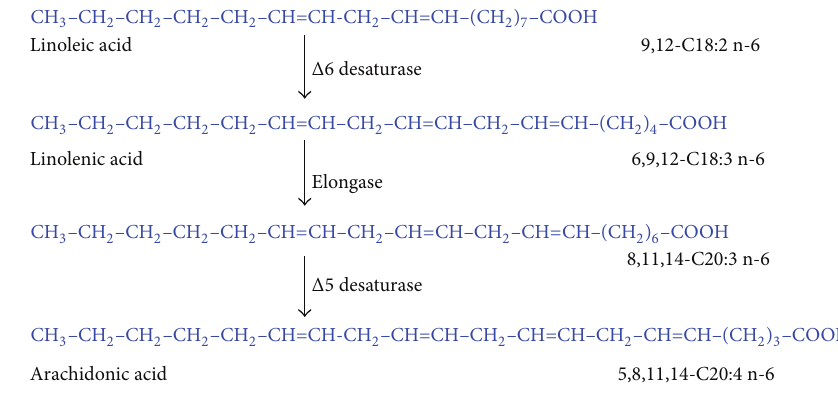
Figure 2: Scheme of the major route of biosynthesis of arachidonic